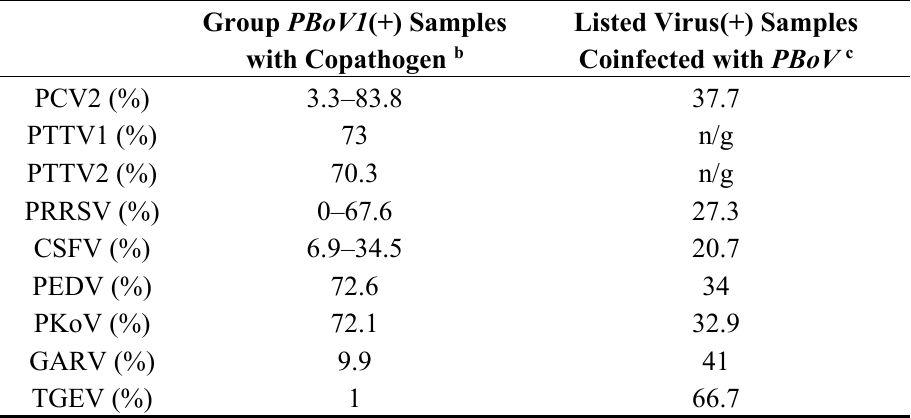
Table 3. Group PBoV1 co-infection in relation to common diarrhea